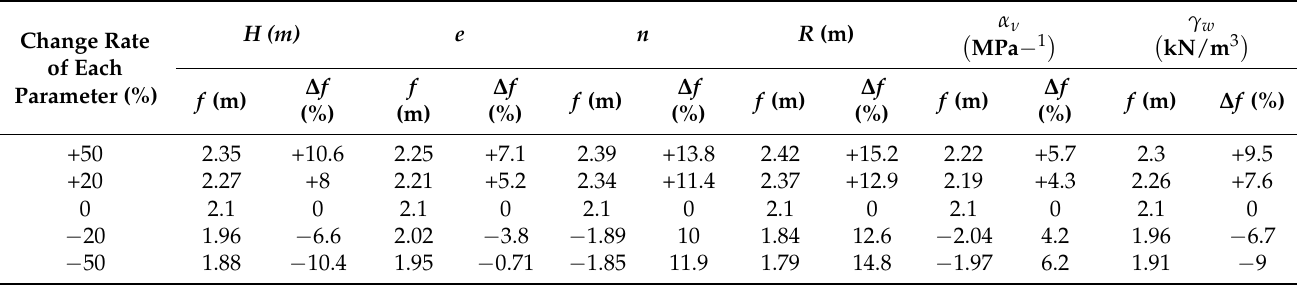
Table 2. Sensitivity analysis of parameter change to